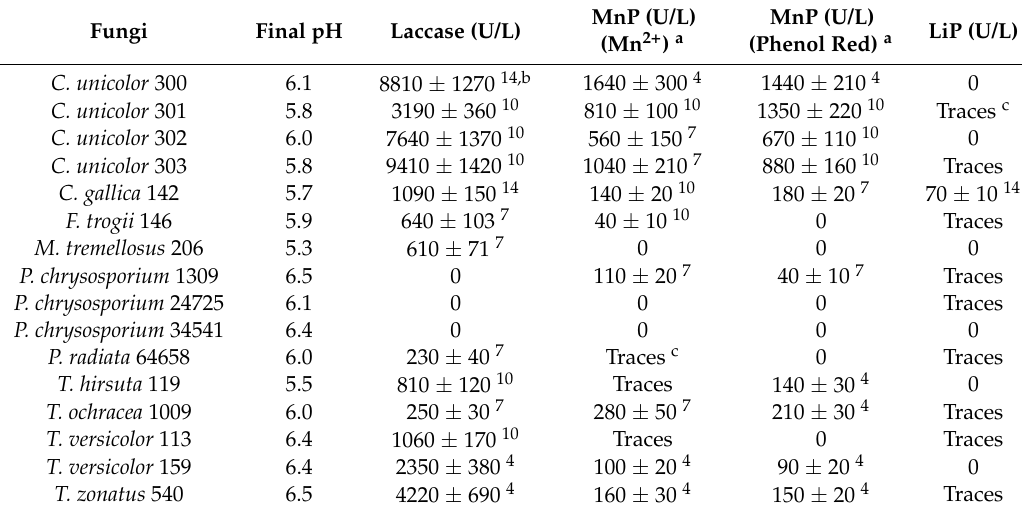
Table 1. Screening of WRB for LME production in the synthetic glycerol-containing medium. Fungi were grown in shake flasks for 14 days at 27 ◦ C ( P. chrysosporium at 37 ◦ C); the nutrient medium contained 10 g/L glycerol as a carbon source and 0.3 g/L veratryl alcohol as an enzyme synthesis